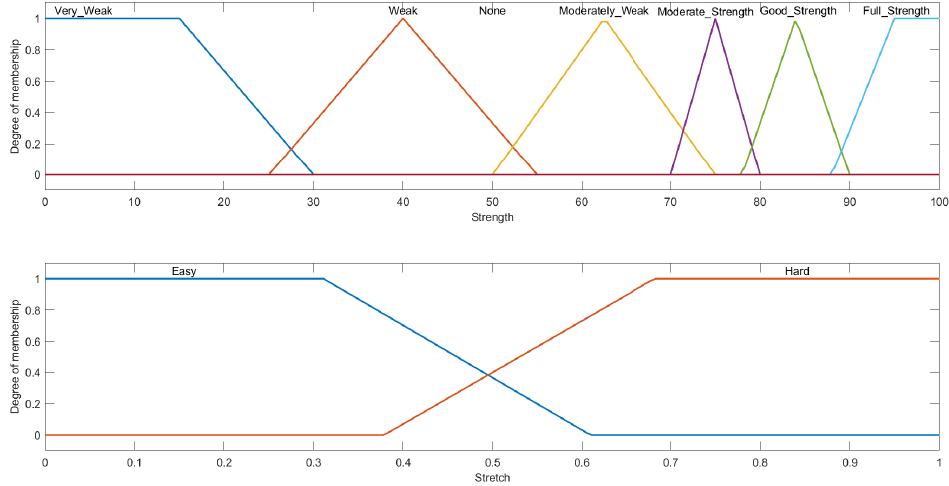
Figure 7. The output membership functions for strength/stretch